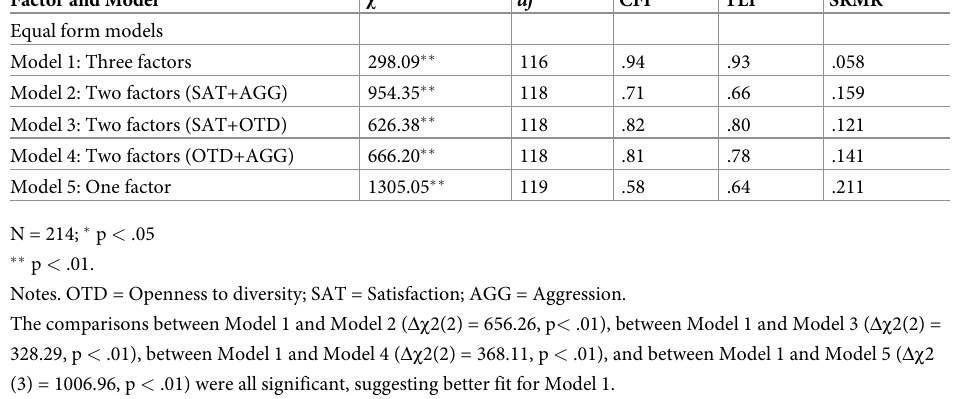
Table 2. Fit indices for measurement model analyses. Factor and